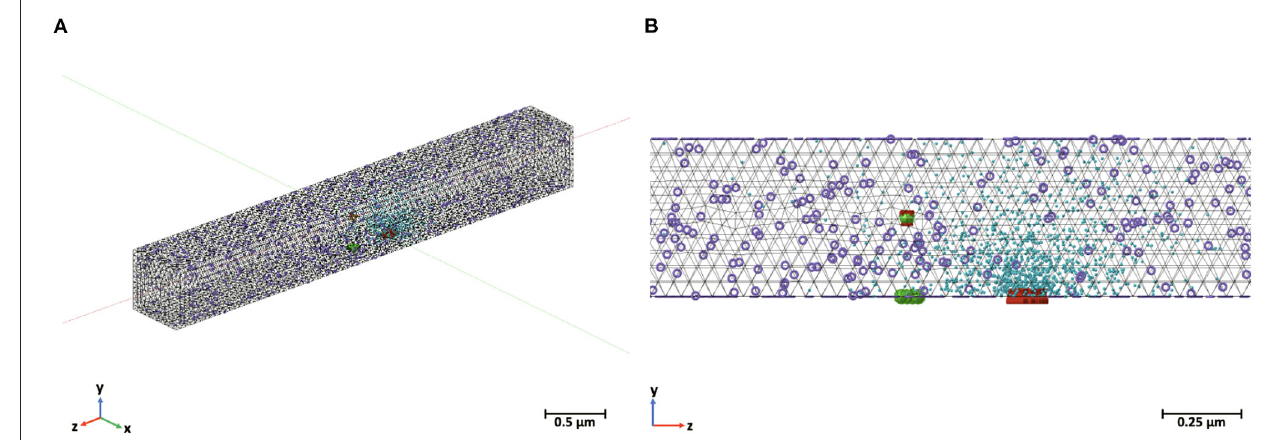
FIGURE 5 | MCell model for synaptic transmission containing voltage-dependent calcium channels (red), calcium (blue), calcium sensors (green), and plasma membrane calcium ATPase pumps (purple). Calbindin not pictured here due to their large number. (A) Entire 0.5 µ m by 0.5 µ m by 4 µ m box representing one vesicular release site in a Schaffer collateral axon in the CA3 region and (B) a close-up of the release site.